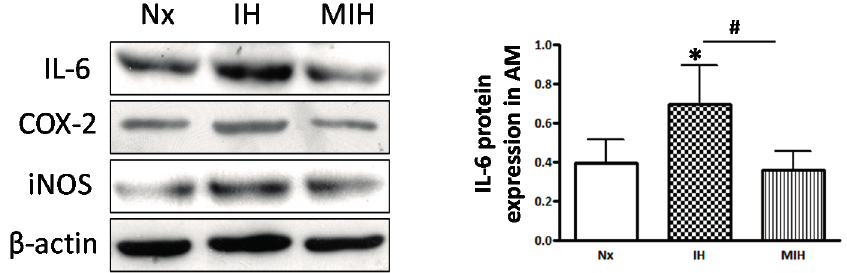
Figure 4. Levels of the protein expression of pro-inflammatory cytokines and mediators in adrenal medulla. ( A ) Protein expression of pro-inflammatory mediators were significantly higher in the IH group than those of the normoxic control and MIH groups; and ( B ) Protein expression of pro-inflammatory cytokines characterized by ELISA. (* p < 0.05, versus normoxic control; # p < 0.05, versus IH group. n = 6 per group). Nx, normoxic control; IH, intermittent hypoxia; MIH, melatonin-treated intermittent